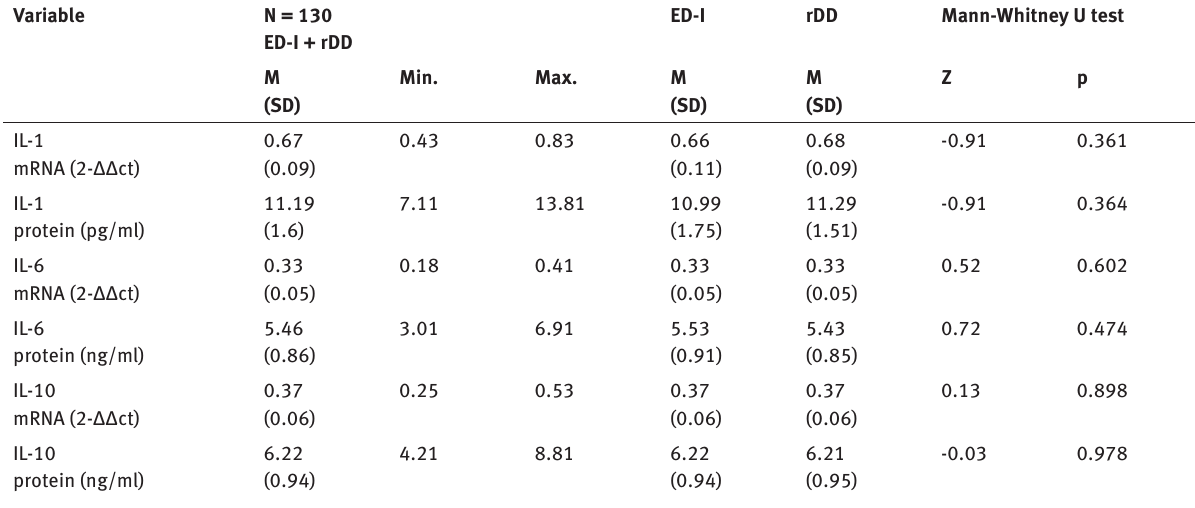
Table 3: Comparison of expression of the analyzed genes at the mRNA level and protein level in the affected from the ED-I and rDD group.